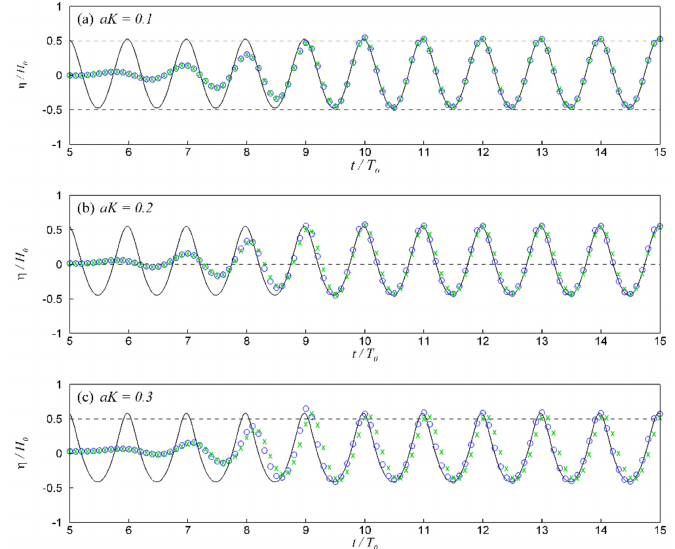
Figure 8. Comparison of the predicted free-surface displacement time series at x = 3 λ for ( a ) aK = 0.10, ( b ) aK = 0.20, and ( c ) aK = 0.30: analytical solution (solid lines), FNHS mode (circles), and QNHS mode (X